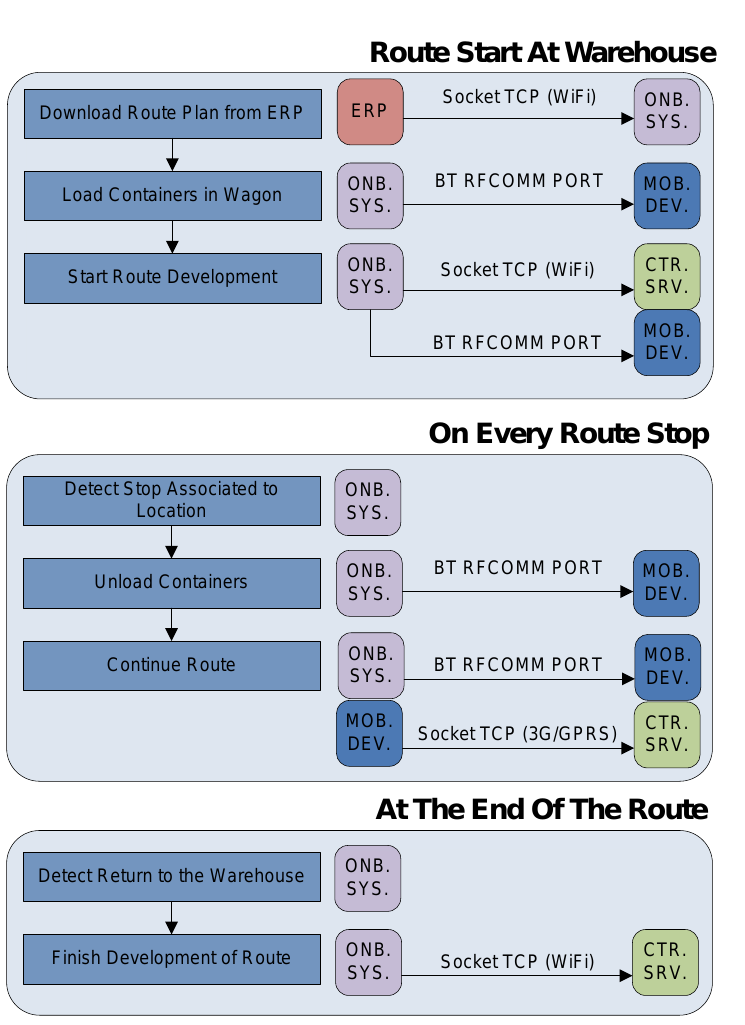
Figure 1. Process flow diagram of the